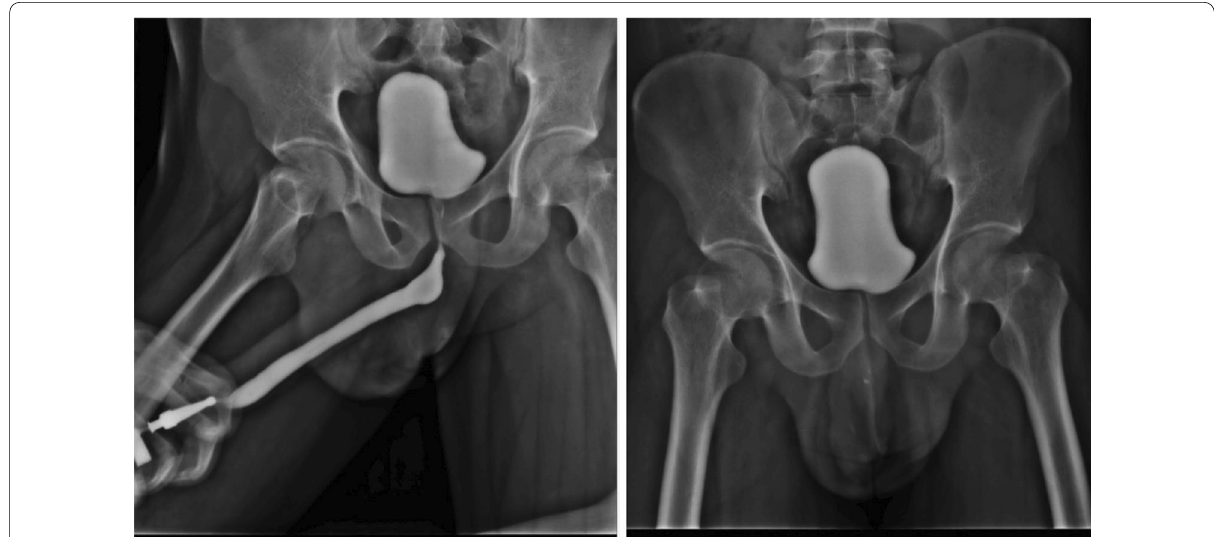
Fig. 1 RGU and cystogram showing normal urethra and pear-shaped bladder